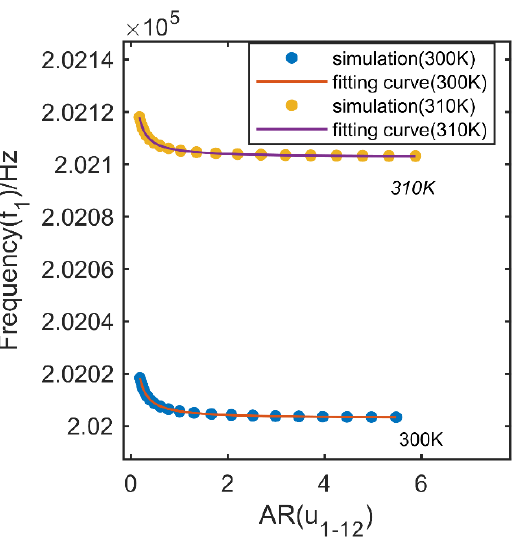
Figure 4. FEM simulation for the relationship between amplitude and resonant frequency under different temperature.